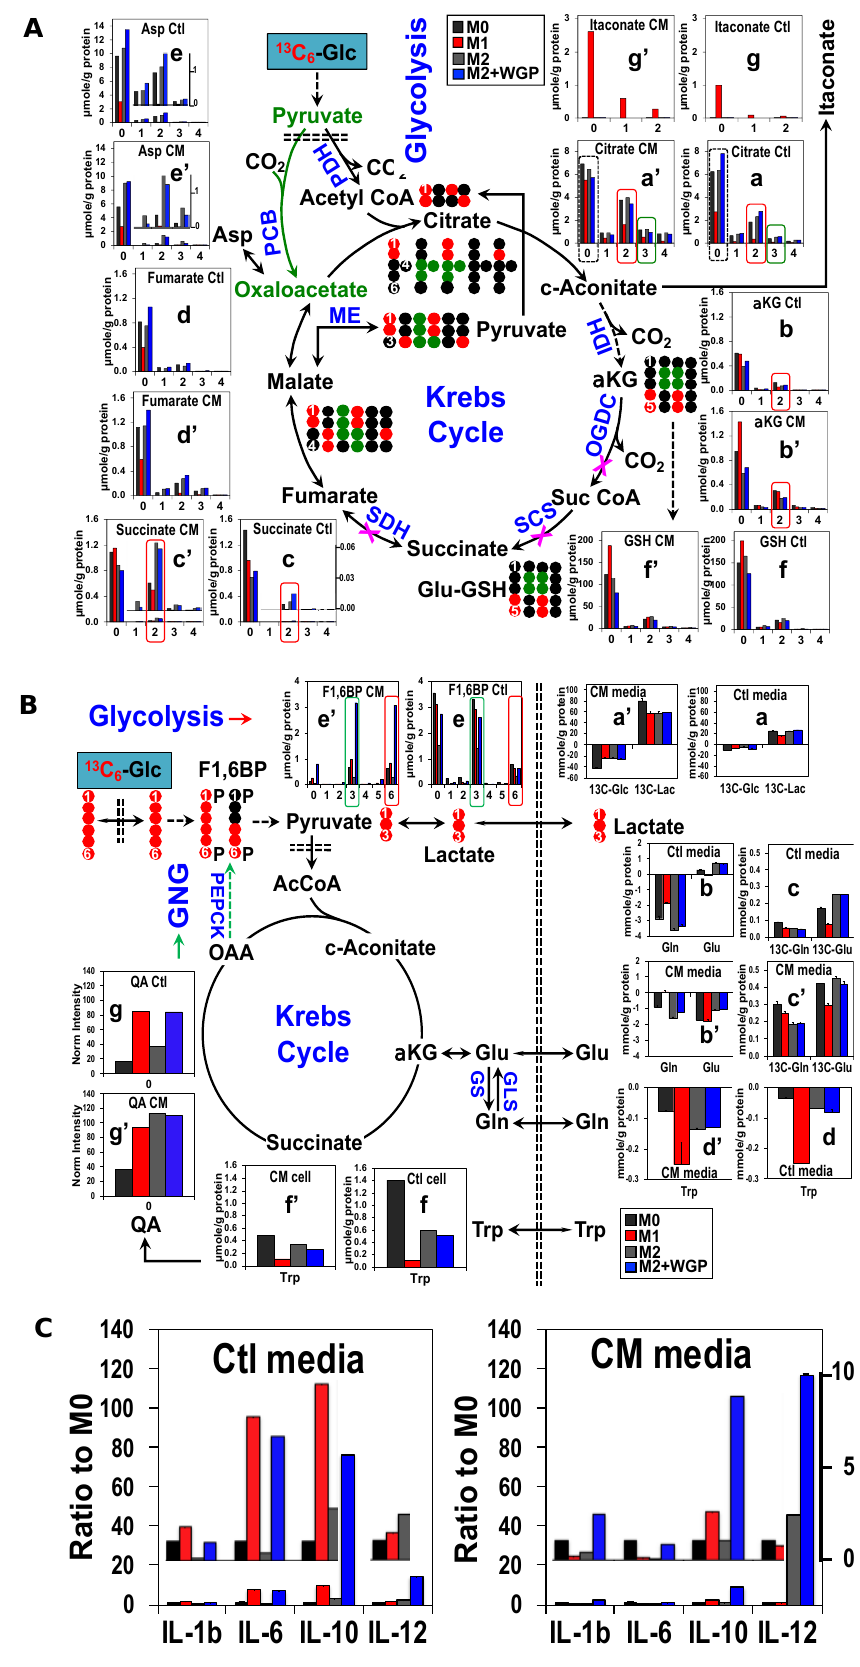
Figure 2. A549 cancer cell conditioned medium alters metabolic response of human macrophage (M φ ) spheroids to polarization and WGP as tracked by SIRM. The 3D M φ cultures (n = 2) were